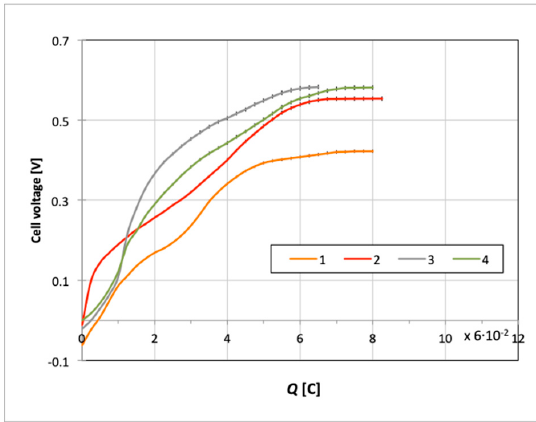
Figure 9. Influence of anodic charge on the catalytic activity of Cu–B alloy containing 12% of B.